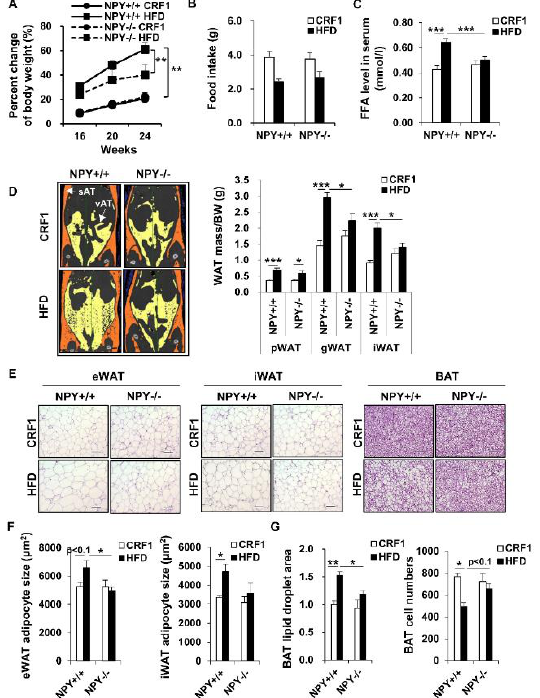
Figure 1. Neuropeptide Y (NPY) − / − mice are resistant to high fat diet (HFD). ( A ) Body weight change during 8 weeks HFD feeding in WT and KO mice. ( B ) Food intake, ( C ) FFA level, ( D ) Representative images of subcutaneous and visceral adipose tissue were determined by 3D-Micro CT (left); perirenal (p), epididymal (e) inguinal adipose tissue (iWAT) mass upon sacrifice (right), ( n = 6–12 per group), ( E ) Representative H&E (hematoxylin and eosin) staining of eWAT, iWAT, and BAT. Scale bar, 100 µ m, ( F ) The mean sizes of adipocyte from eWAT and iWAT ( G ) BAT cell number ( n = 4 per group), All data are presented as the mean ± SEM, Student’s two-tailed t test, * p < 0.05, ** p < 0.01, and *** p <